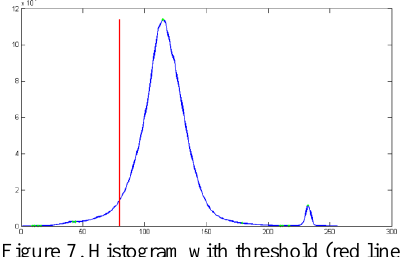
Figure 7. Histogram with threshold (red